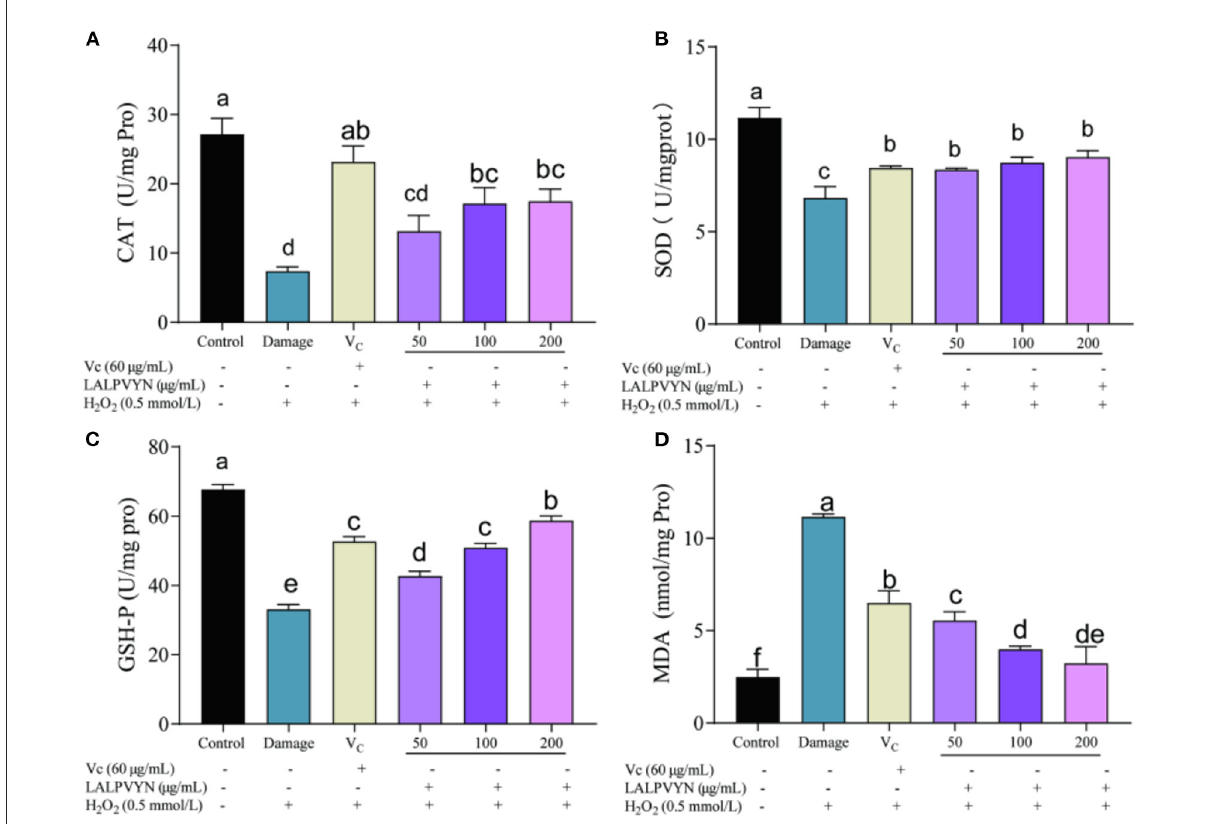
FIGURE5 Effect of LALPVYN pretreatment on SOD, CAT, GSH-Px, and MDA of H 2 O 2 -mediated oxidative injured HepG2 cells. (A) Effect of LALPVYN on CAT, (B) effect of LALPVYN on GSH-Px; (C) effect of LALPVYN on SOD; (D) effect of LALPVYN on MDA. Data are expressed as mean ± SD from three independent experiments ( n = 3), results marked with the same letters were not significantly different ( P >